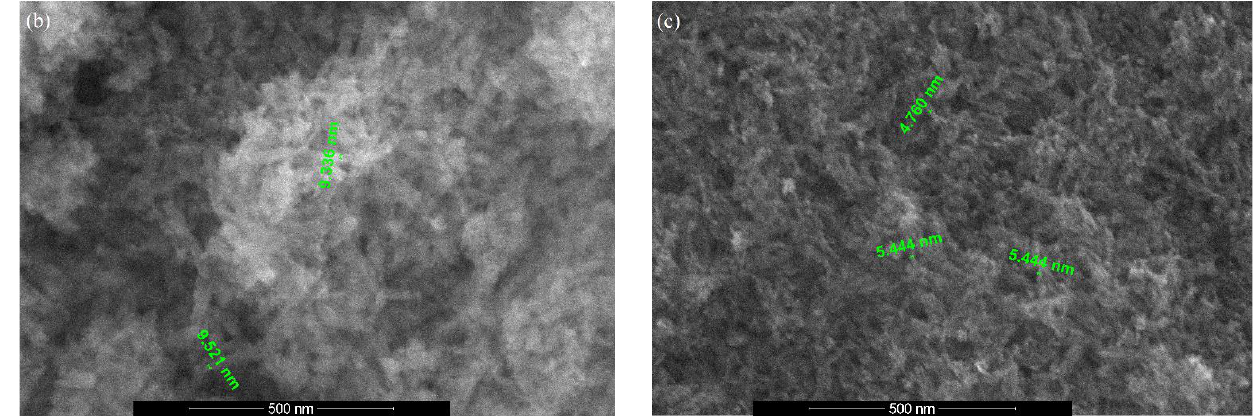
Figure 5. The SEM image of ( a ) pure HAp; ( b ) Ca 9.5 Ce(III) 0.5 (PO 4 ) 6 (OH) 2 and ( c ) Ca 9.5 Ce(IV) 0.5 (PO 4 ) 6 (OH) 2 .